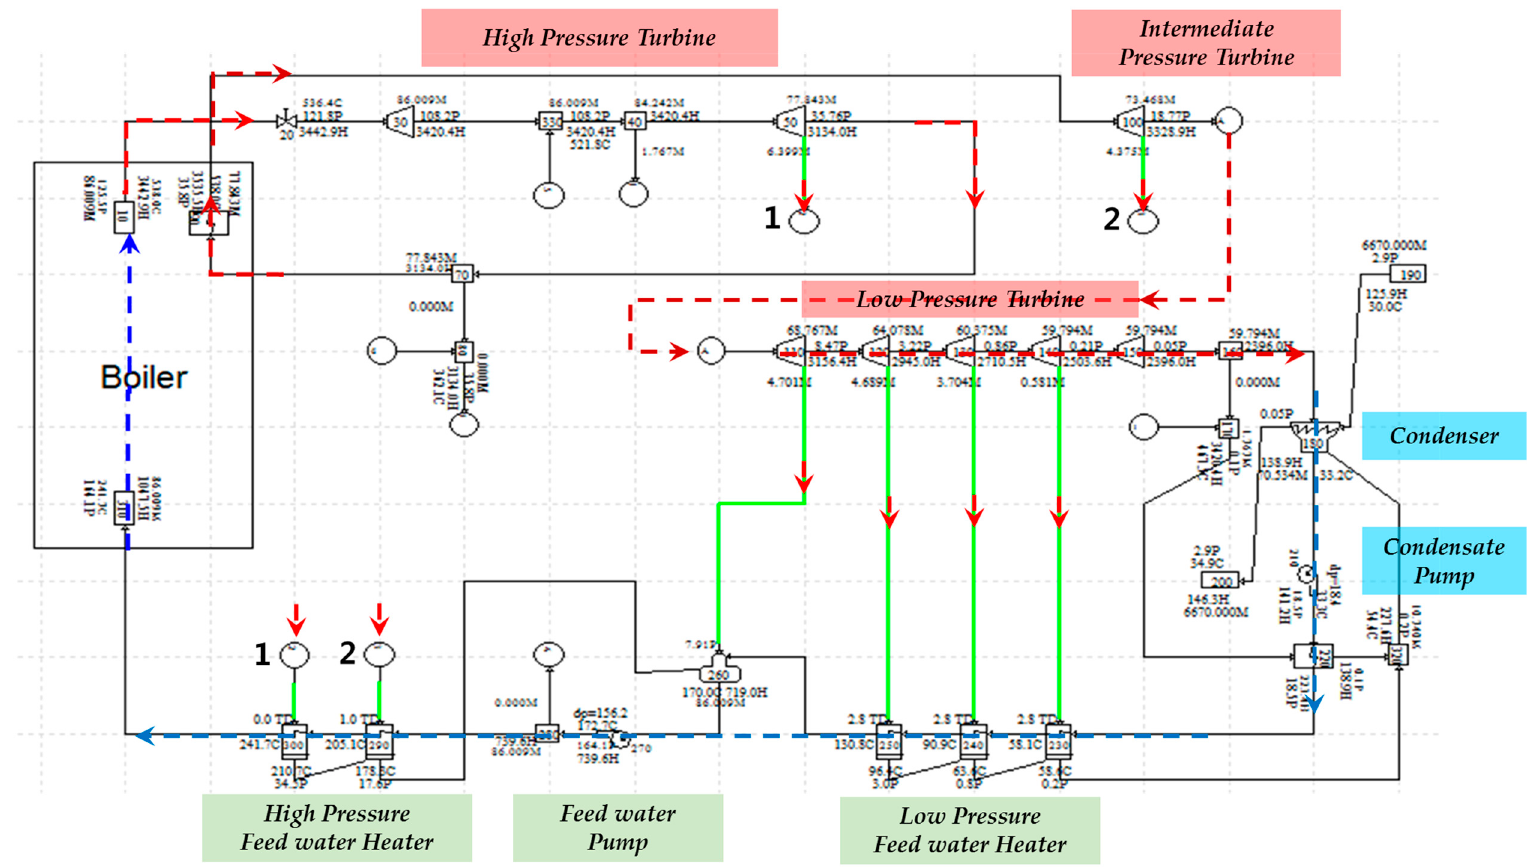
Figure 4. Computational Model for the Turbine Steam Cycle.